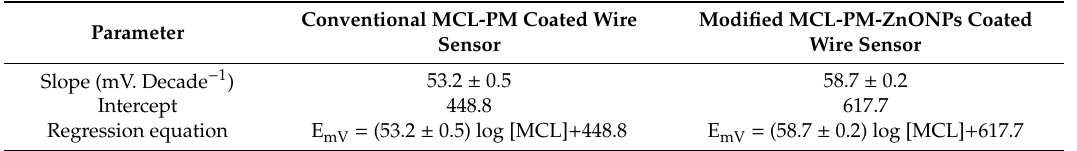
Table 1. Characteristic responses of conventional coated wire MCL-PM and modified MCL-PM- ZnONPs-coated wire